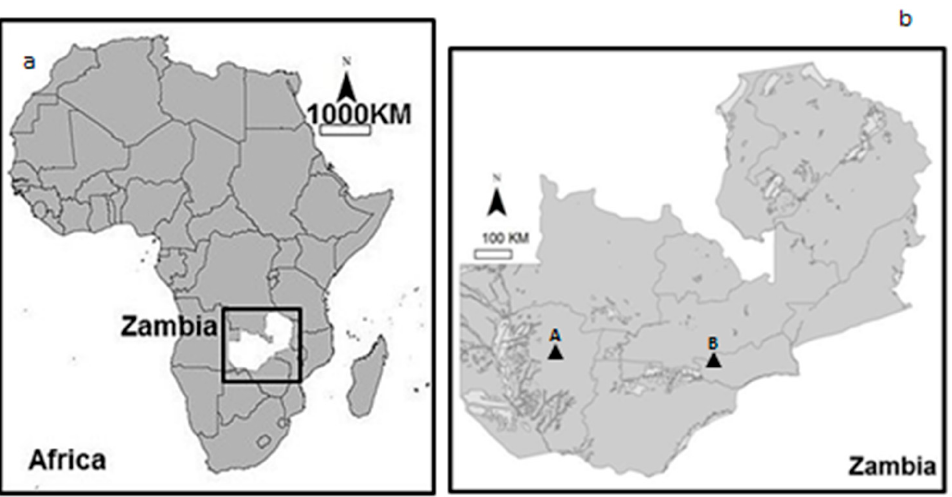
Figure 1. ( a ) Map of Africa showing location of Zambia; ( b ) Map of Zambia showing location of Mongu (A) and Lusaka (B).